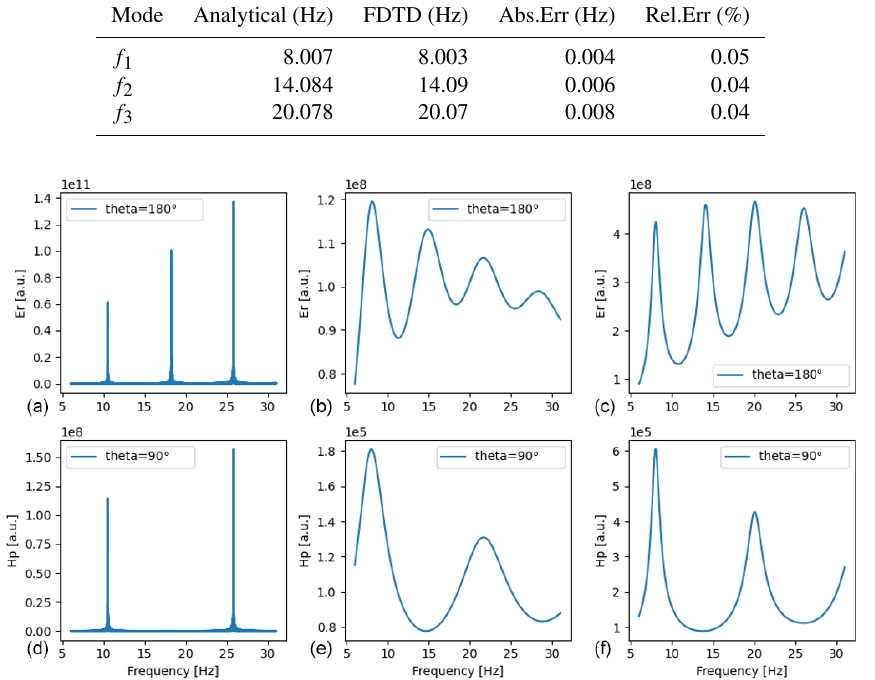
Figure 1. The FDTD spectrum for spherical waveguide with a lossless perfect cavity (a, d) , one conducting layer (b, e) , and two layers (c, f) for an electric component at 90 ◦ and a magnetic component at 180 ◦ .